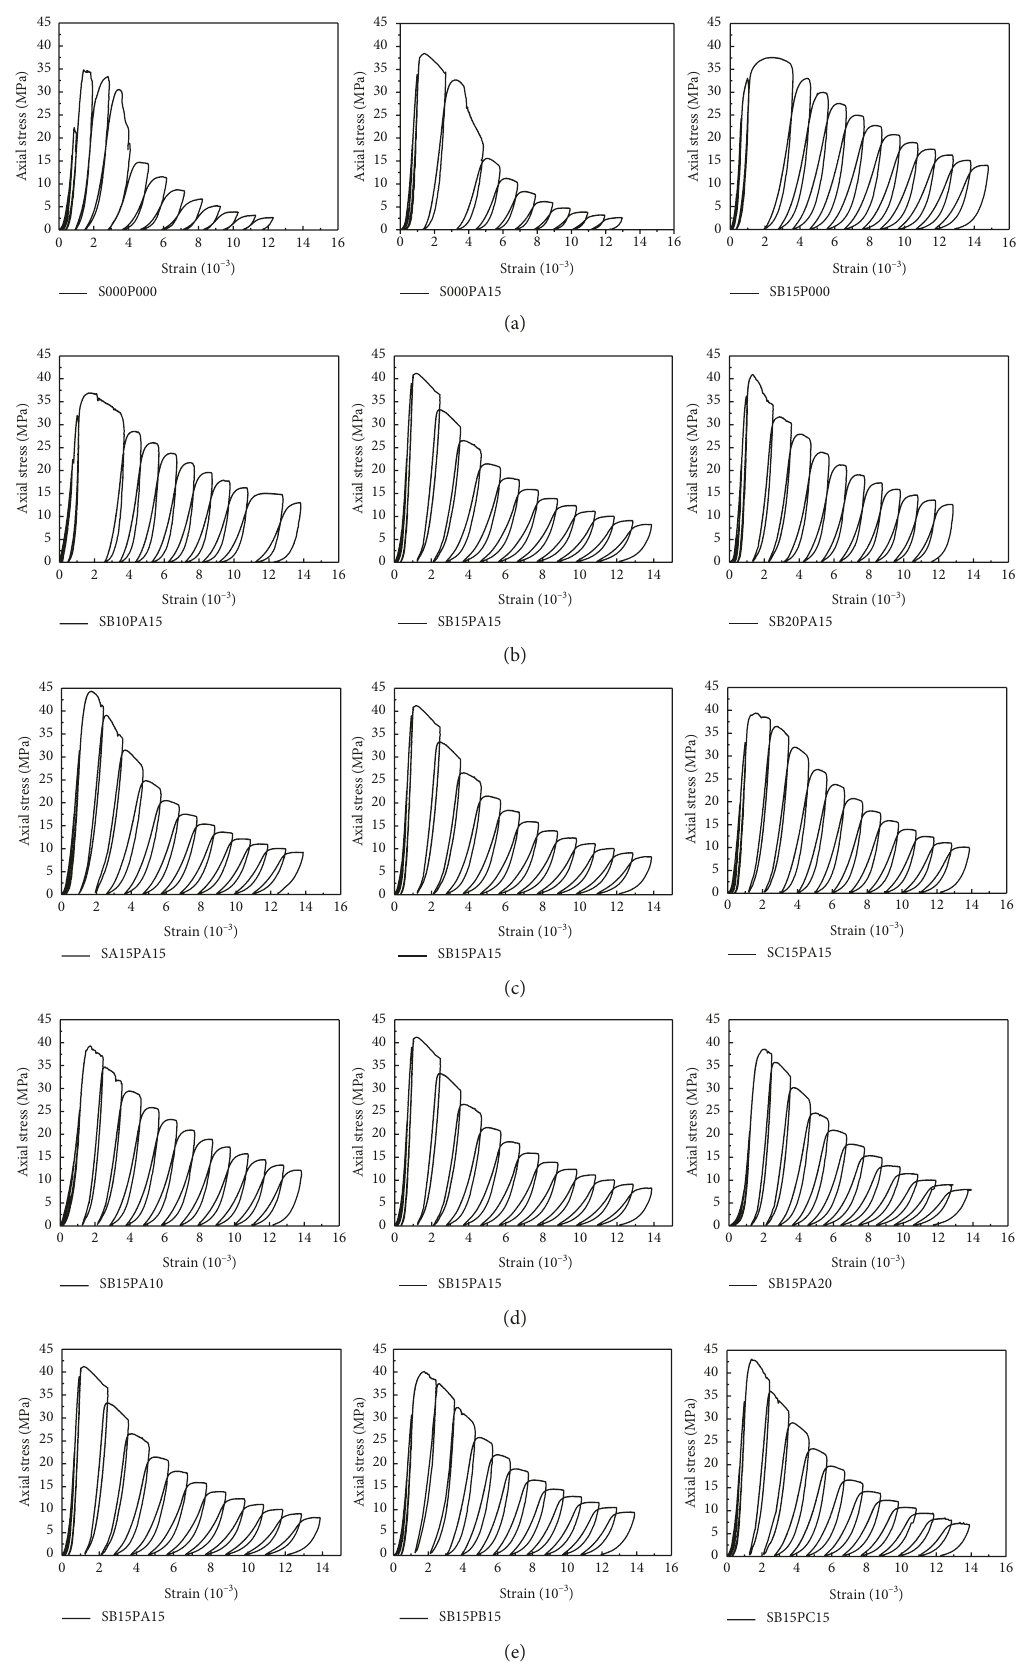
Figure 6: Cyclic stress-strain relations of BFRC specimen for various fiber volume fractions and aspect ratios. (a) Effect of fiber types. (b) Effect of volume fraction of SF. (c) Effect of aspect ratio of SF. (d) Effect of volume fraction of PF. (e) Effect of aspect ratio of